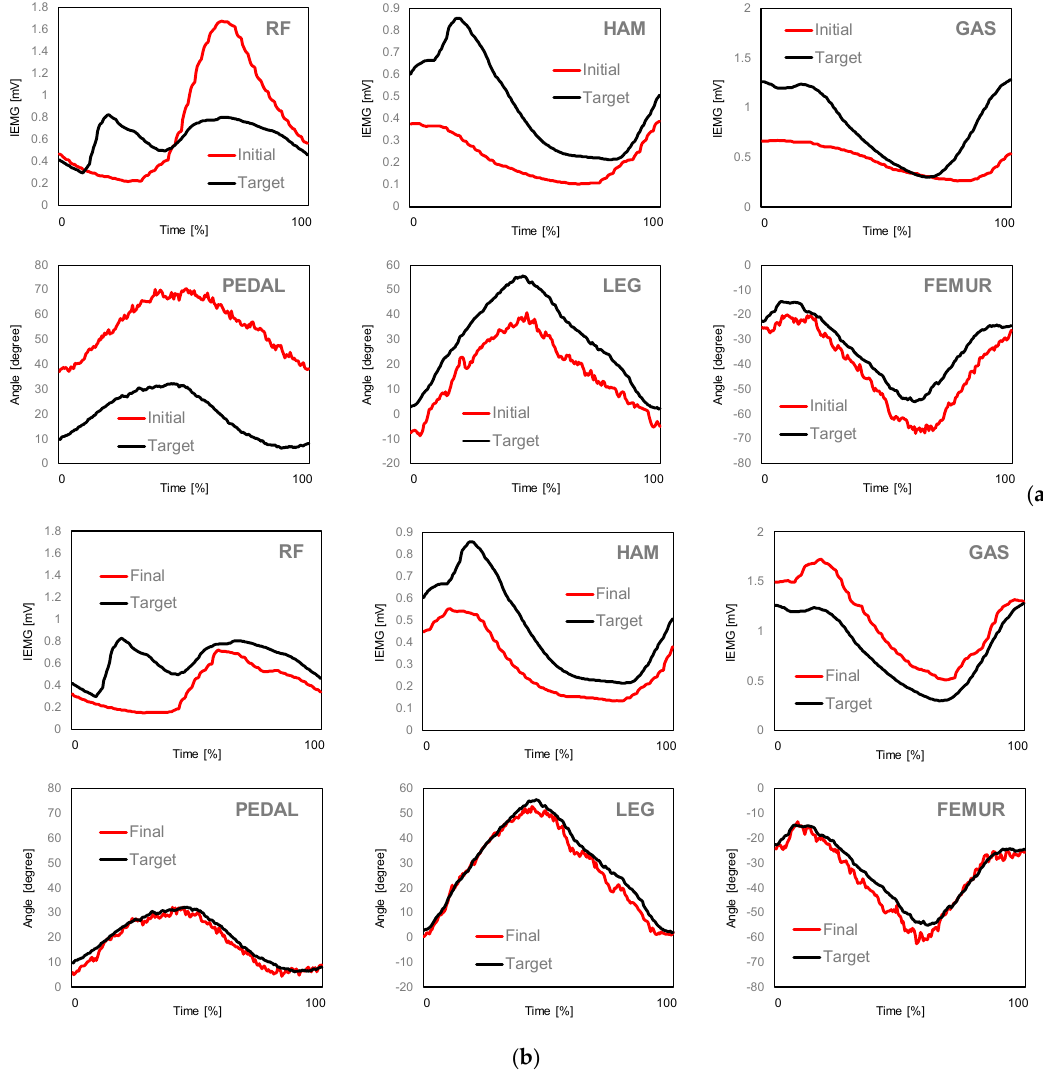
Figure 4. Motor skills information recorded by seven wireless sensors during the proposed feedback training. ( a ) Motion data in the initial stage of the training experiment. ( b ) Motion data in the final stage of the training